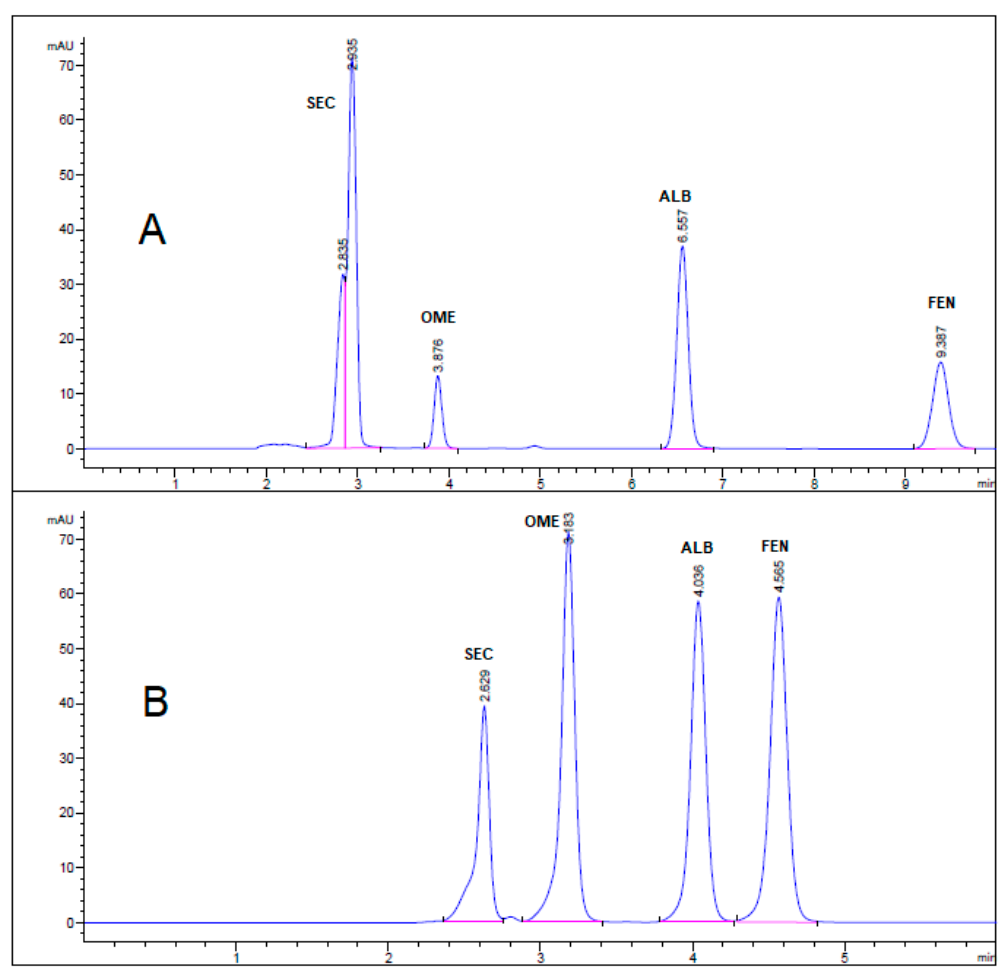
Figure 3. HPLC chromatogram of authentic mixture containing 25 µg/mL SEC, OME, ALB, and FEN using mobile phase ( A ) acetonitrile: 0.025 M KH 2 PO 4 (60:40, v/v ) buffer, pH 3.20 and ( B ) methanol: 0.025 M KH 2 PO 4 (70:30, v/v ) buffer, pH 3.20. Other chromatographic conditions are stated in Table 1. Table 1. Chromatographic Conditions for the proposed method.